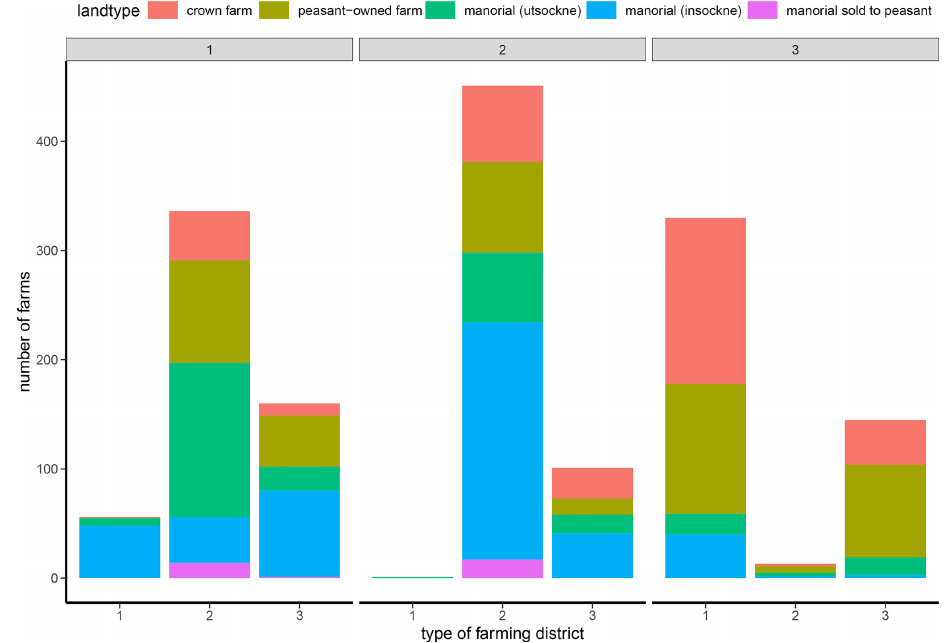
Figure 4. Institutional status of farms, including type of farming district. Each bar plot represents a cluster with each cluster denoted in the grey-marked area. 1 denotes plain districts, 2 mixed districts, and 3 forest districts. Source: HDSA.